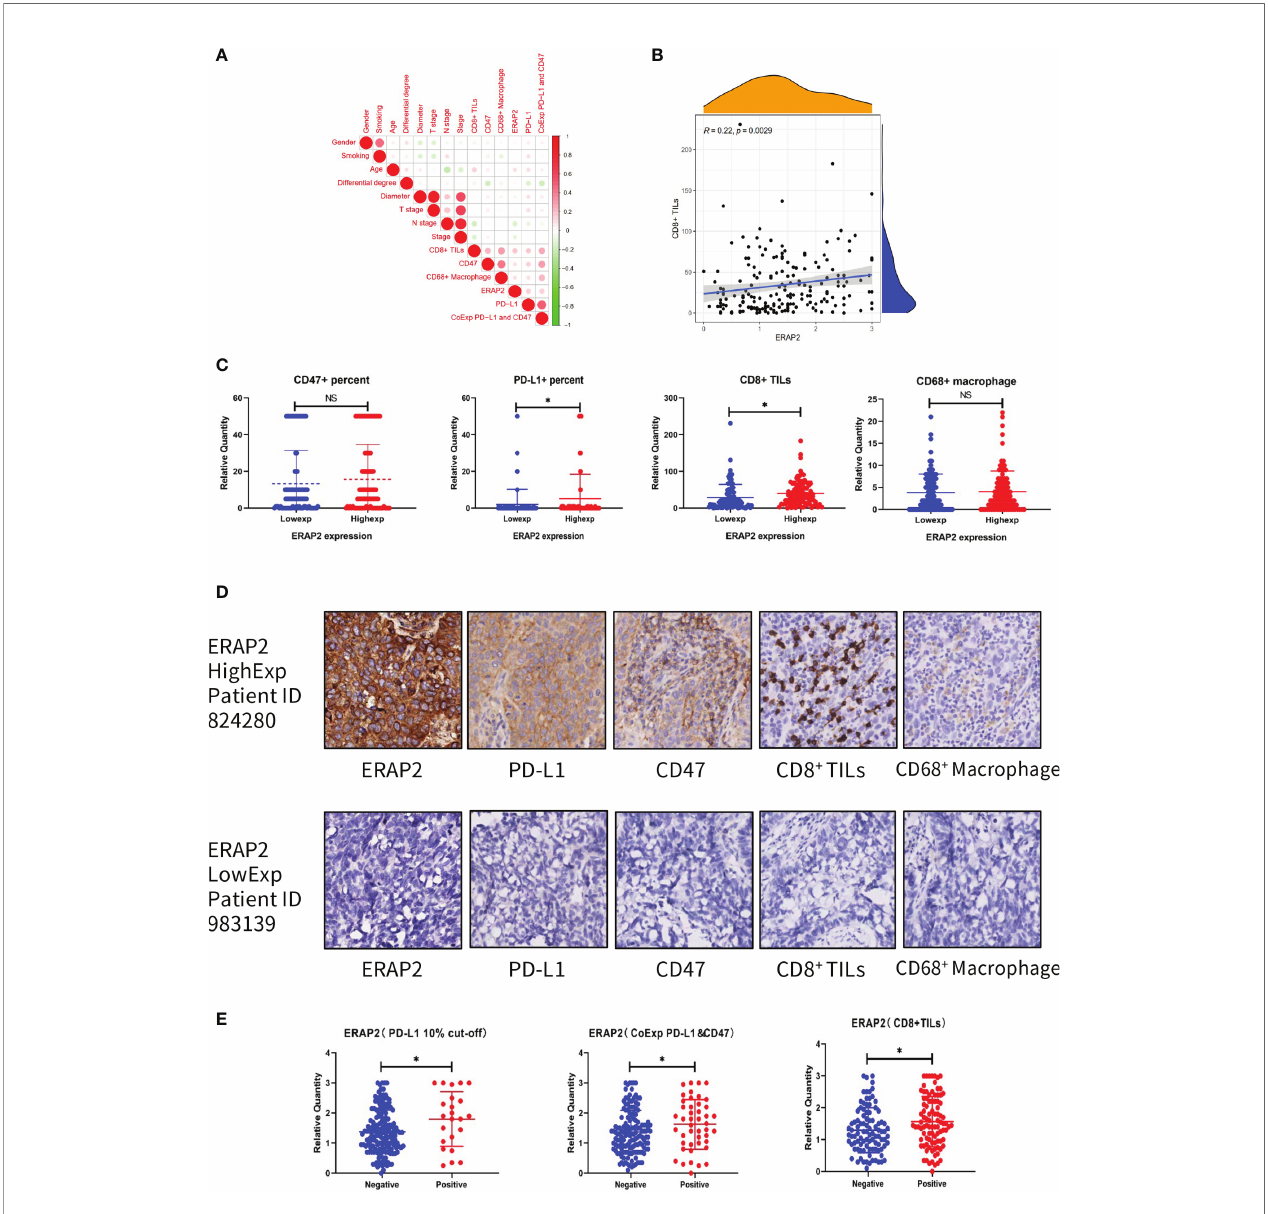
FIGURE 6 | Association between ERAP2 expression and multiple immune markers in our SqCLC TMA. (A) Associations among all clinicopathological and immune markers in SqCLC TMAs. The circle color represents the correlational tendency. The circle size represents the statistical signi fi cance. Red, positive correlation. Green, negative correlation. Larger circle represents the lower p-value. (B) Correlation between ERAP2 expression and CD8+ TILs. Spearman relevant coef fi cient = 0.22, p-value=0.0029. (C) The relative quantity of immune markers in ERAP2 high and low expression patients of SqCLC TMAs. From left to right: CD47, PD-L1, CD8, and CD68. Blue, ERAP2 low expression group. Red, ERAP2 high expression group. Asterisk, p-value<0.05. (D) IHC images of representative patients in the ERAP2 high and low expression group (100×). Upper: representative patient with high ERAP2 expression. Lower: representative patient with low ERAP2 expression. From left to right: ERAP2, PD-L1, CD47, CD8 + TILs and CD68 + Macrophages. (E) The relative quantity of ERAP2 among patients with different immune marker statuses. From left to right: PD-L1, PD-L1 and CD47 co-expression, CD8+ TILs. Asterisk, p-value <